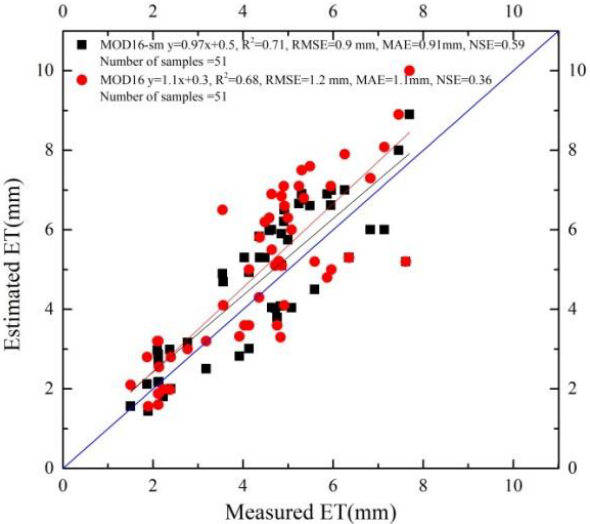
Figure 4. The comparison between ET observations and estimates by the MOD16 and MOD16-sm model. To make further analyses on the MOD16 and MOD16-sm model, comparisons of daily average ET on a monthly scale are displayed in Table 2. Daily average ET values estimated by the MOD16-sm model at the four stations were much closer to measured ET